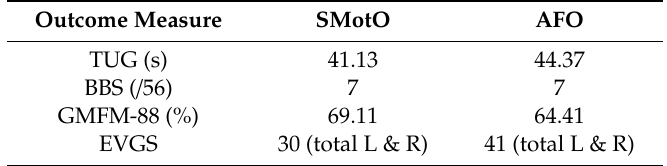
Table 3. Participant 2 outcome measure comparative results between SMotO and AFO.